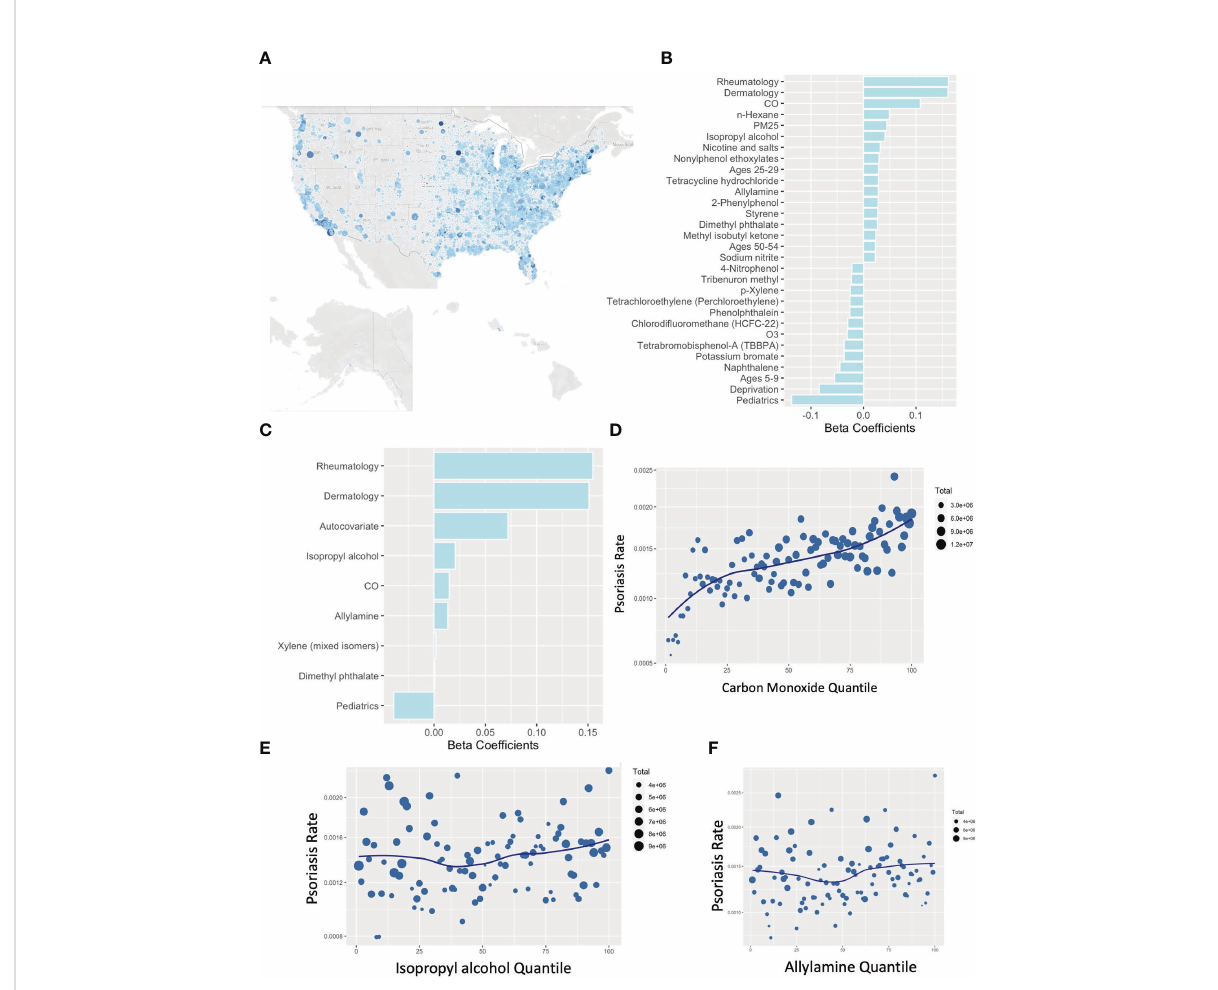
FIGURE 3 Rates of psoriasis associate with carbon monoxide by US zip code. (A) Map of rates of psoriasis (clinical visits billing for psoriasis divide by total billable visits) by US zip code. (B, C) Lasso Poisson regression models using non-spatial (B) or spatial (C) assessments pollutants associated with psoriasis. (D – F) Percentile plots for concentration of CO (D) , isopropyl alcohol (E) , and allylamine (D) against rates of